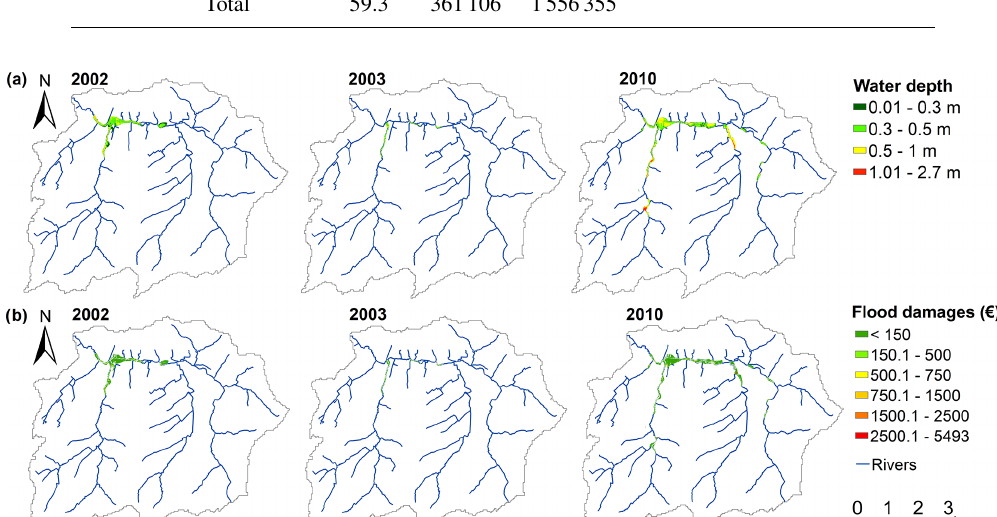
Figure 7. (a) The inundation depth (m) and (b) the corresponding flood damage (EUR) per pixel (5m × 5m resolution) derived from the flood damage model in the Maarkebeek catchment resulting from the observed flood events. The total flood damage was EUR566667, 27515, 139650 and 1556355, respectively, for the flood events in February 2002, in August 2002, in January 2003 and in November